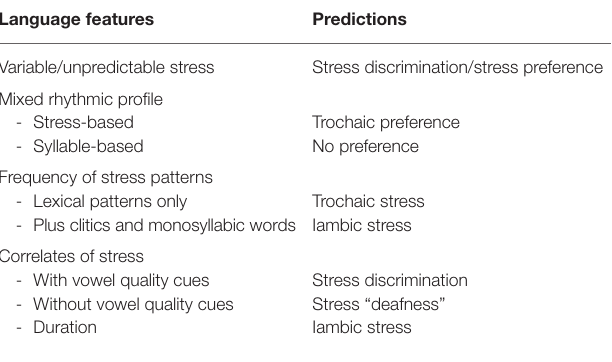
TABLE 1 | Features of European Portuguese (EP) and predictions for the development of stress perception in the first year of life. Language